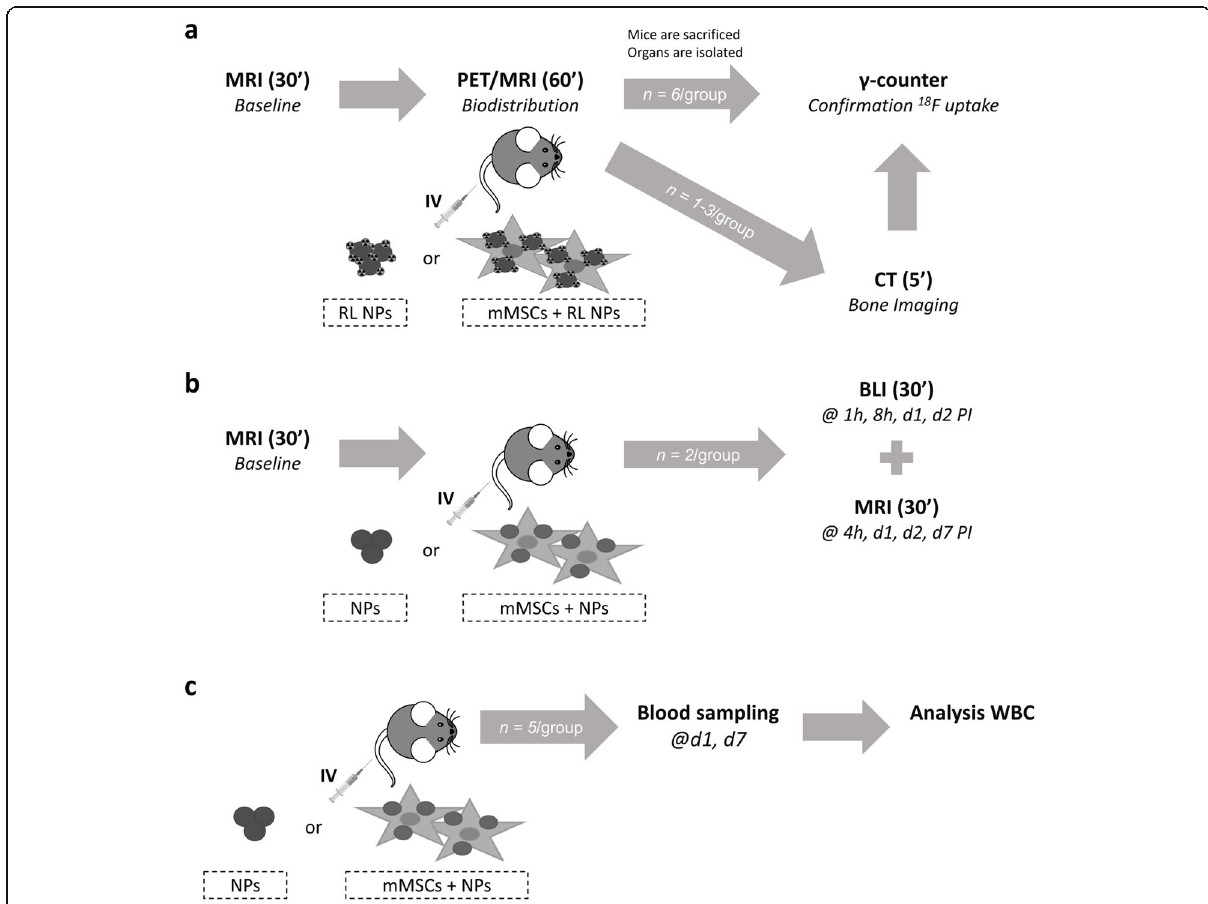
Fig. 1 Experimental overview. a After acquisition of baseline MRI scans, 18 F-labeled Fe 3 O 4 @Al(OH) 3 nanoparticles (radiolabeled; RL NPs) or mouse mesenchymal stem cells (mMSCs) labeled with such NPs (mMSCs + RL NPs) are injected intravenously (IV) during simultaneous PET/MRI acquisition to follow-up their respective short-term biodistribution over time. In the control group, saline or free [ 18 F]NaF was injected. Afterwards, a small cohort of mice underwent CT imaging to visualize uptake in bones. Finally, animals were sacrificed; different organs were isolated and analyzed using the gamma-counter. b Biodistribution of non-RL (cold) NPs or mMSCs labeled with them was studied over a period of 7days post-injection (PI) using both MRI and bioluminescence imaging (BLI) after the IV injection of the NPs/cells. c After IV injection of cold Fe 3 O 4 @Al(OH) 3 nanoparticles or mMSCs labeled with them, blood samples were taken on day one and day seven PI to analyze the white blood cell (WBC) population. Control groups in b and c were injected with